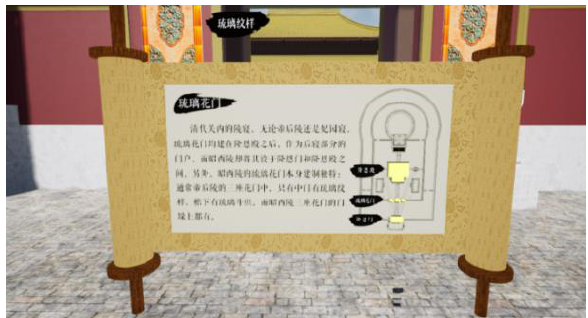
Figure 13. The reel next to the Gate of Coloured Glaze